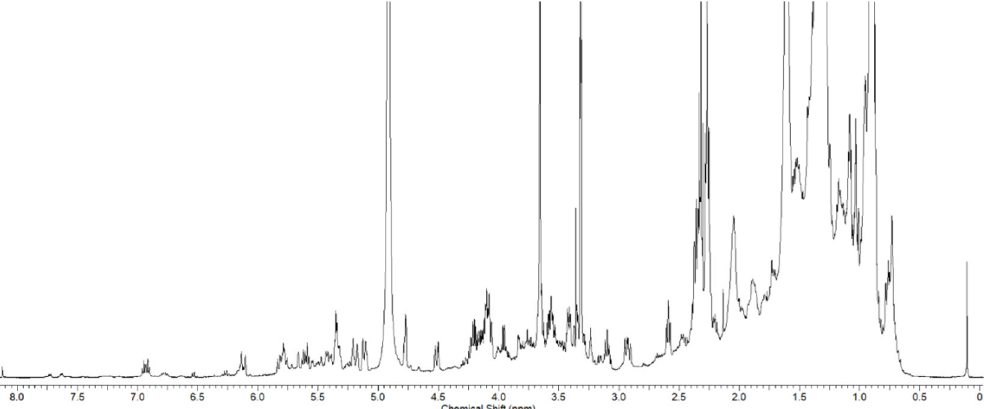
Figure 1. 1 H NMR spectrum of the M2 fraction of Turbinaria ornata extract (TOE) in CD 3 OD (500 MHz for 1 H).